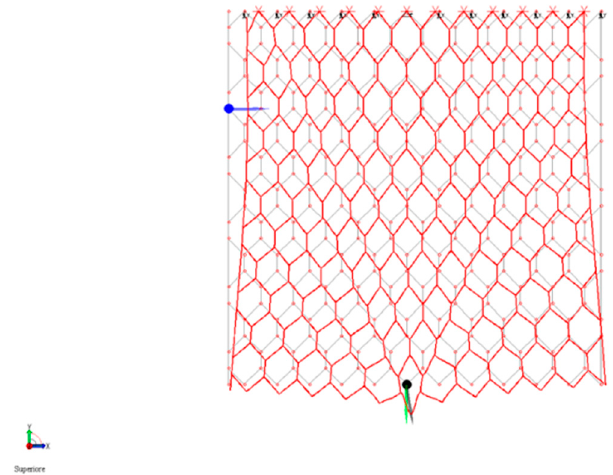
Figure 10. Amplified deformed configuration of the DTWM caused by the application of a concentrated load of 160 N.